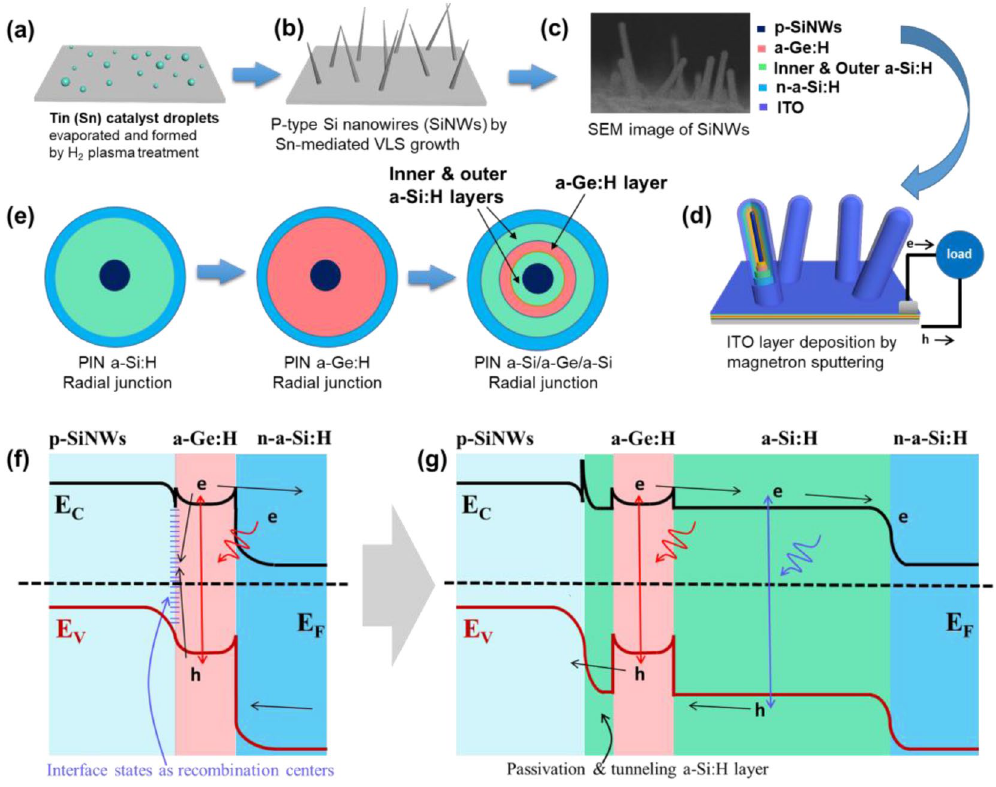
Figure 1. ( a – d ) Illustrate the fabrication procedures of PIN RHJ PAL/a-Ge:H/a-Si:H PD. ( e ) illustration of three types of Radial juntions: PIN a-Si:H RJ, PIN a-Ge:H RJ, PIN a-Si:H/a-Ge:H/a-Si:H RJ. ( f ) Sketches of the energy band profiles of PIN RHJ a-Ge:H PD where Ec is the conduction band and Ev is the valence band. ( g ) Sketch of PIN RHJ PAL/a-Ge:H/a-Si:H PD, showing the a-Ge:H quantum well confined by the a-Si:H